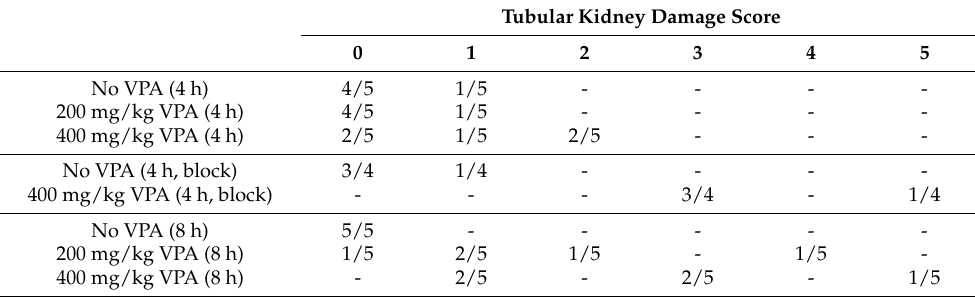
Table 1. Tubular kidney damage scores (scale: 0–5) given to each experimental